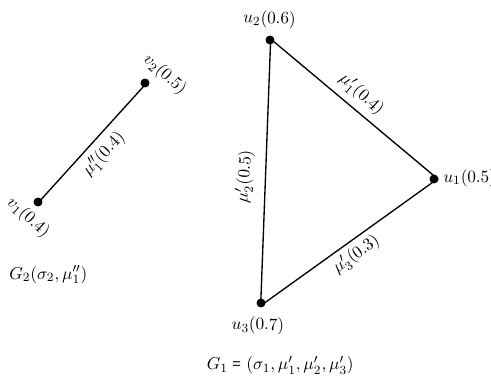
Figure 7. Two fuzzy-graph structures G 1 and G 2 . Figure 7: Two Fuzzy Graph Structures G 1 and G 2 Figure 7: Two Fuzzy Graph Structures G 1 and G 2